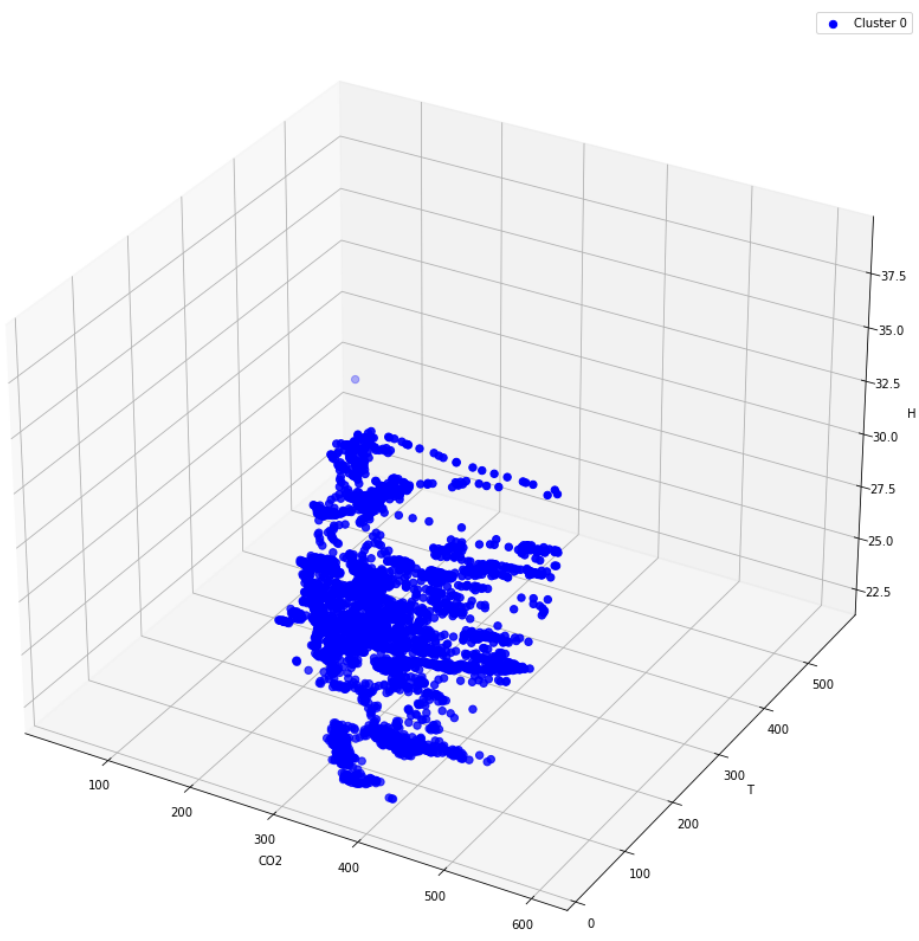
Figure 3. Cluster analysis of the air sensor data.